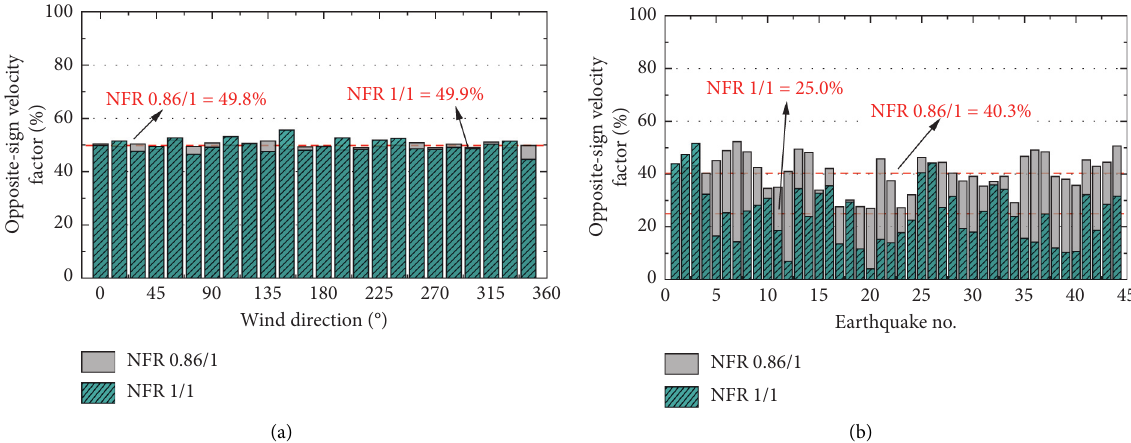
Figure 10: Variation of opposite-sign velocity factor at 210.2m height under (a) 24 wind directions and (b) 44 earthquake